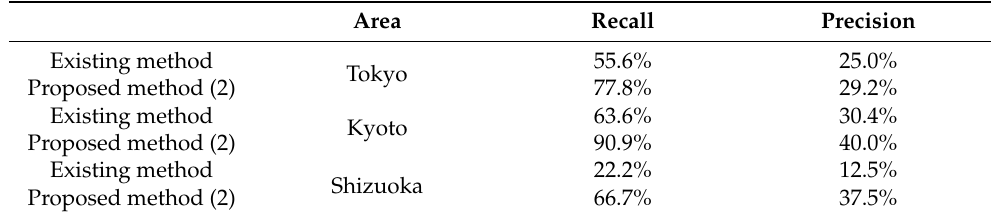
Table 8. Recall rate and precision rate between existing method and proposed method (2), in 2021.